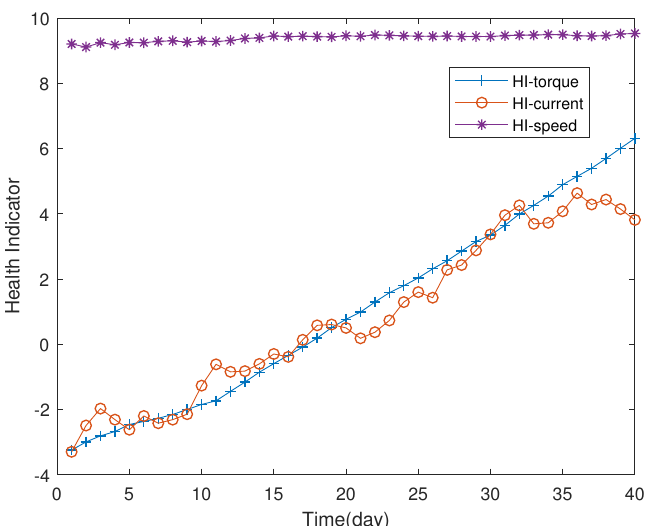
Figure 8. The different health indicators computed from the torque, current, and speed signals. The process of estimating a broken rotor’s RUL is triggered once the degradation is detected based on HI-torque and HI-current. The degradation model is used to detect the time evolution trends of HI-torque and HI-current, to update its parameters by looking at newly available observations, and to estimate when the FT is crossed. The parameters of this model are determined using the HI values. At the beginning, the parameters are initialized as θ = 1, β = 1, var ( θ , β ) = 10 6 , and φ = − 1, so that the degradation model is mostly relies on the observed HI data. The exponential model can evaluate the significance of the exponential slope by looking at the generated trends of the HIs. Once a significant slope of HIs is detected, the model deletes the previous observations and restarts its estimation based on the original